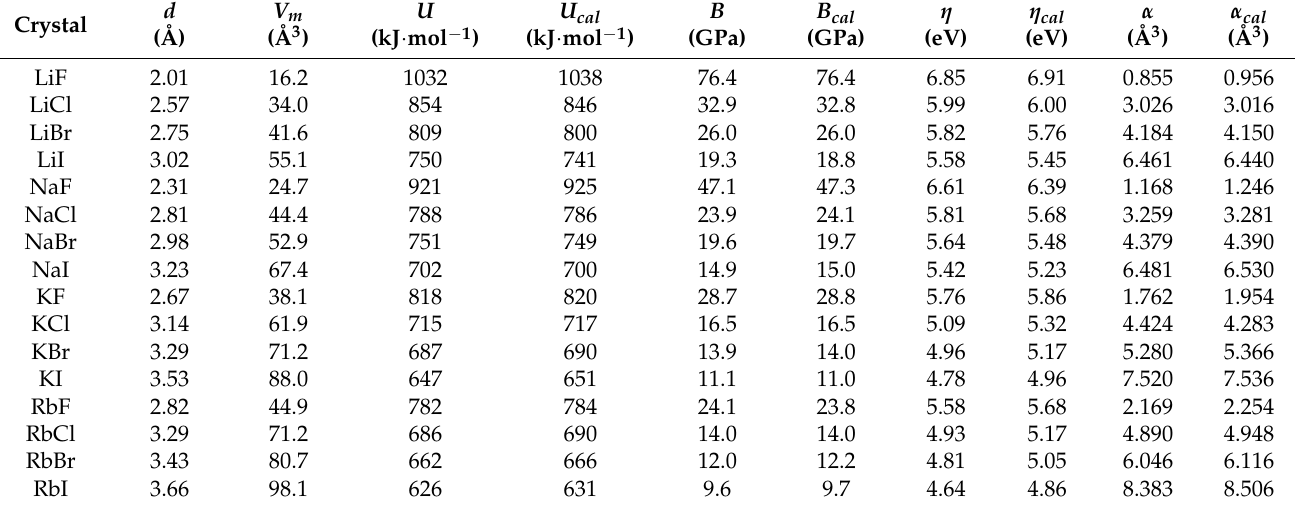
Table 1. Chemical bond length d , molar volume V m , lattice energy U , calculated lattice energy U cal , bulk modulus B and calculated bulk modulus B cal , chemical hardness η , calculated chemical hardness η cal , electronic polarizability α , calculated electronic polarizability α cal of rock salt crystals of group